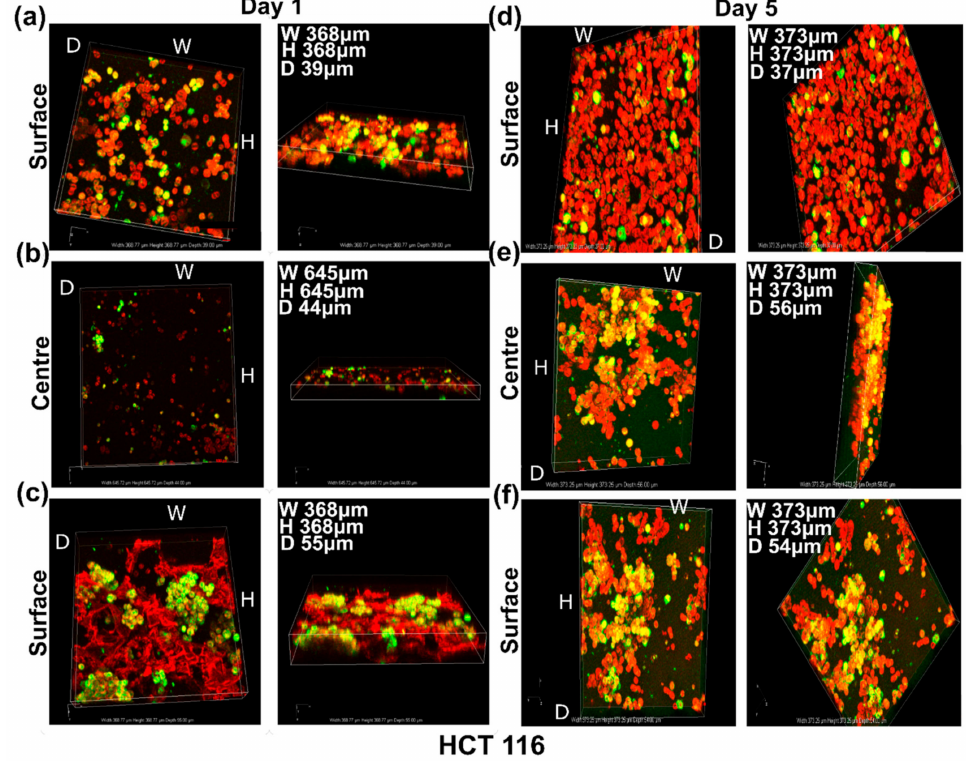
Figure 7. Live cell imaging of HCT116 cells grown on 10 mm × 10 mm × 8 mm 3D PHA scaffolds on Day 1—( a ) upper side, ( b ) centre and ( c ) lower side—and on Day 5—( d ) upper side, ( e ) centre and ( f ) lower side—using TMRM (Red) and Calcein Green (Green), both for live cells. The upper side, lower side and centre of the 3D PHA scaffold were imaged using a Nikon confocal